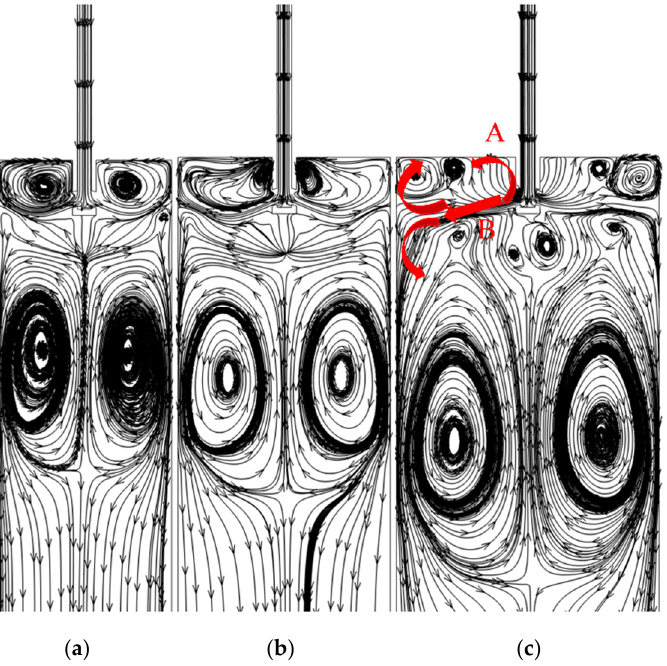
Figure 5. Streamlines on the center longitudinal section of the mold with different mold widths under low steel throughput: ( a ) 880 mm, ( b ) 1050 mm, and ( c ) 1300 mm.